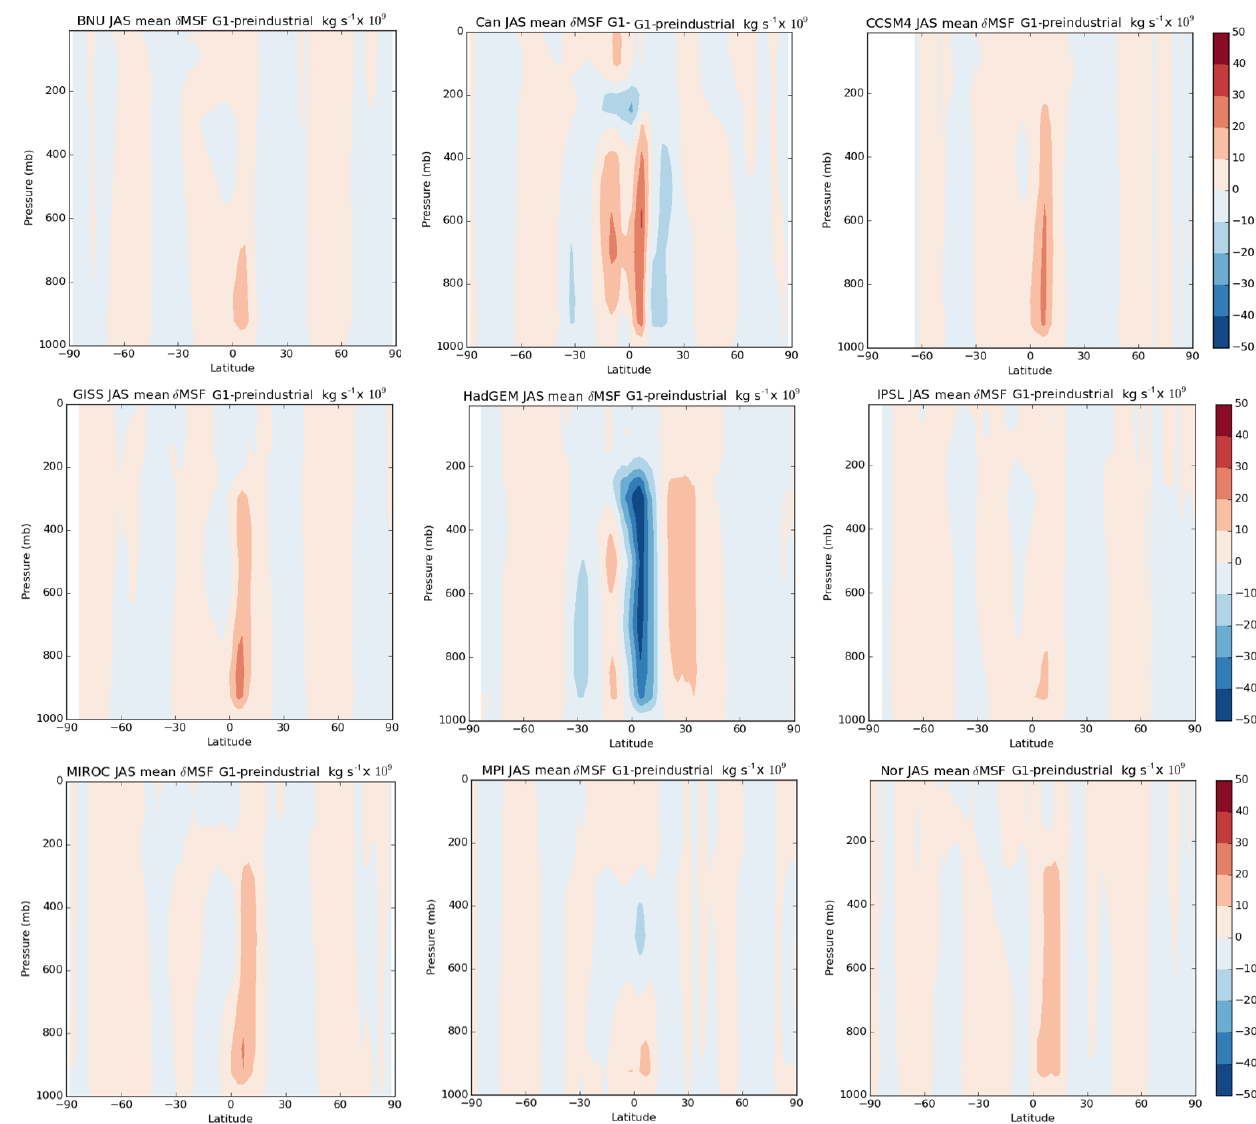
Figure 7. The JAS mean meridional stream function anomaly between G1 (years 11–50) and piControl (last 40 years) in each model, as calculated in Eq. (4). The blue coloring indicates counterclockwise motion (data unavailable for HadC and CESM